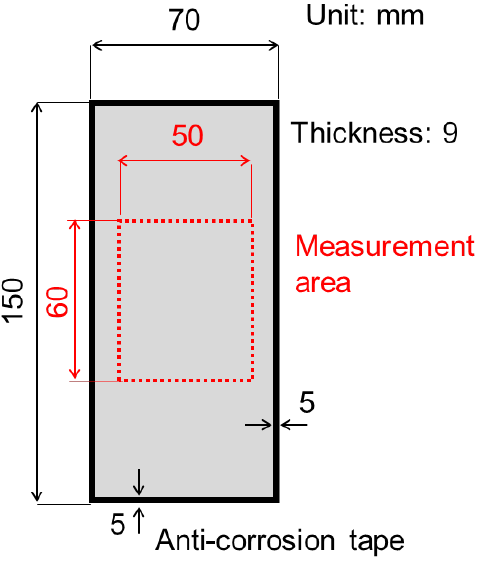
Figure 1. The size of steel plates and corrosion measure